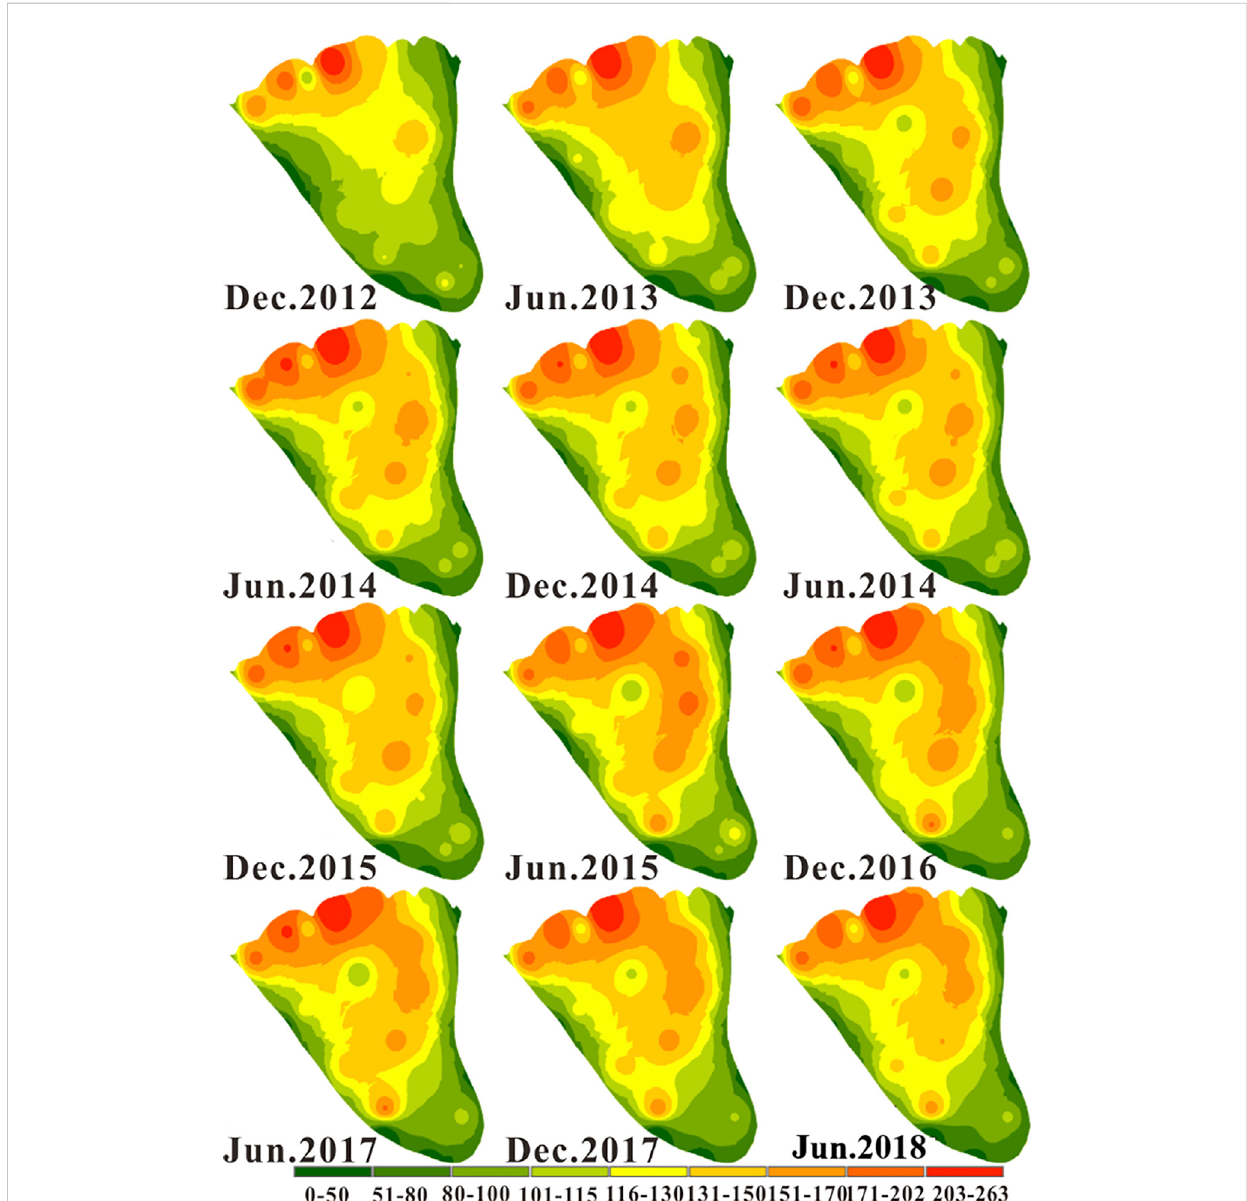
FIGURE 7 Spatial and temporal evolution nephogram of horizontal displacement